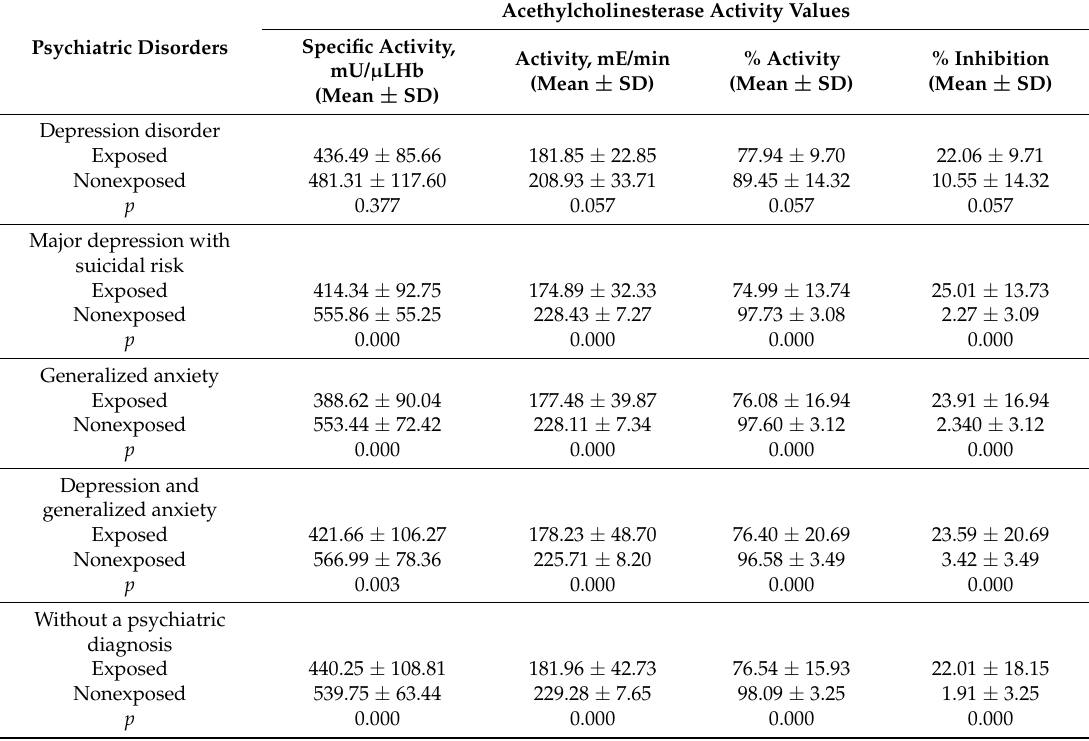
Table 5. Acethylcholinesterase activities of the study population diagnosed with different psychiatric disorders. The p -values for each parameter were obtained by factorial ANOVA, and p < 0.05 was considered statistically